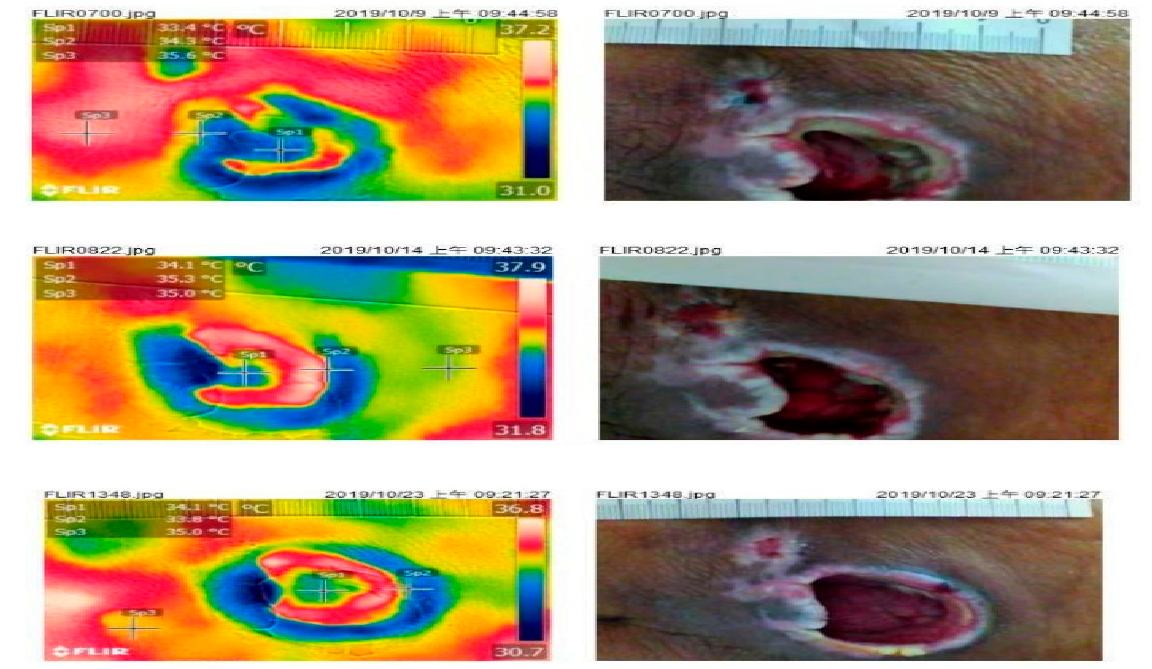
Figure 4. Case of poor wound-healing (upper to lower in the consecutive days). IRTc: wound bed (Sp1) IRTp: periwound skin (Sp2); IRTn: normal skin (Sp3).